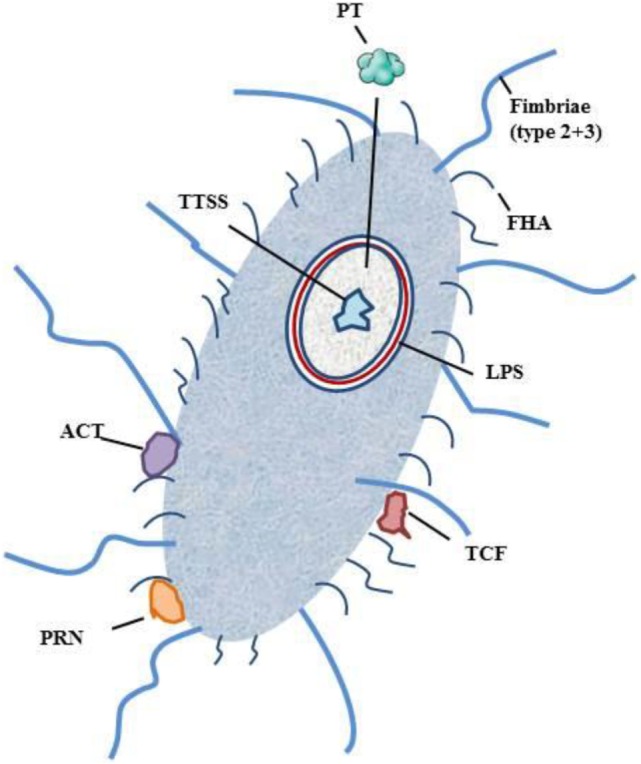
Schematic figure of B. pertussis and its virulence factors. Notation: PT, pertussis toxin; TCT, trachel cytotoxin; ACT, adenylate cyclase toxin; TTSS, type III secretion system; LPS, lipopolysaccharide; FHA, filamentous hemagglutinin; PRN, pertactin.